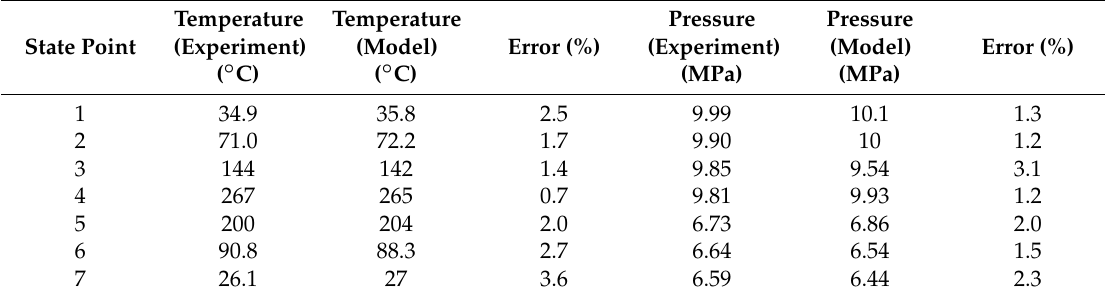
Table 3. Errors between GT-Power model and experiment data.